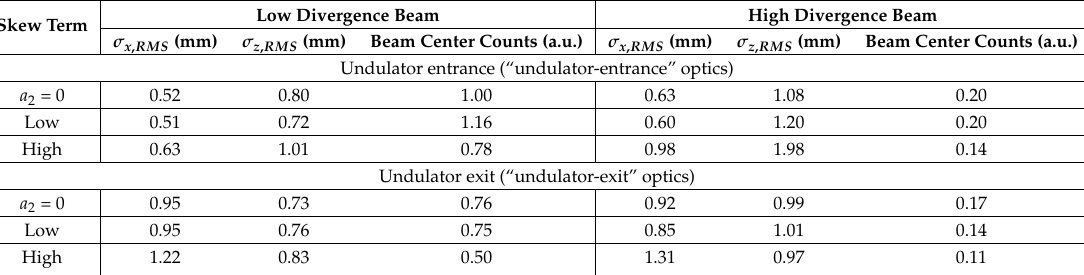
Table 4. Counts at the center of the beam, RMS horizontal and vertical beam size for the different skew cases and beam distributions on the screen before and after the undulator. Each point averaged over 5 repetitions of the simulation.